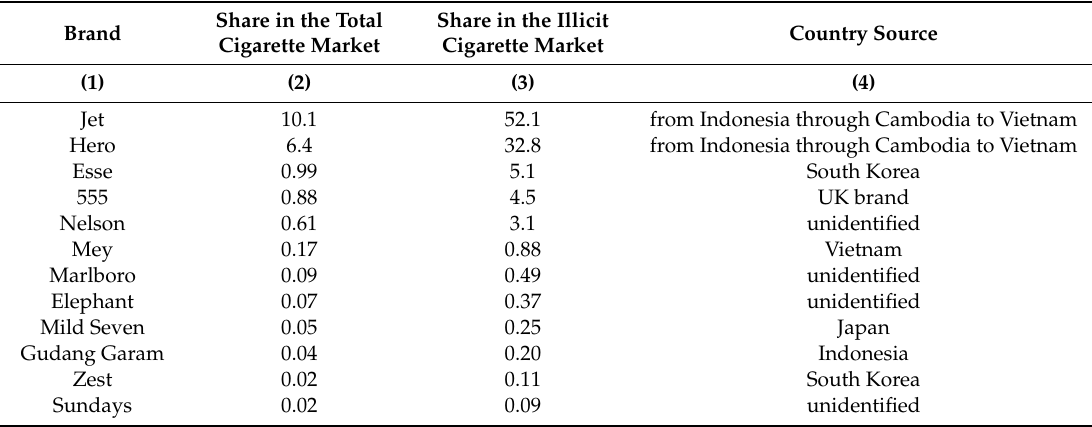
Table 2. Market share and country source of illegal